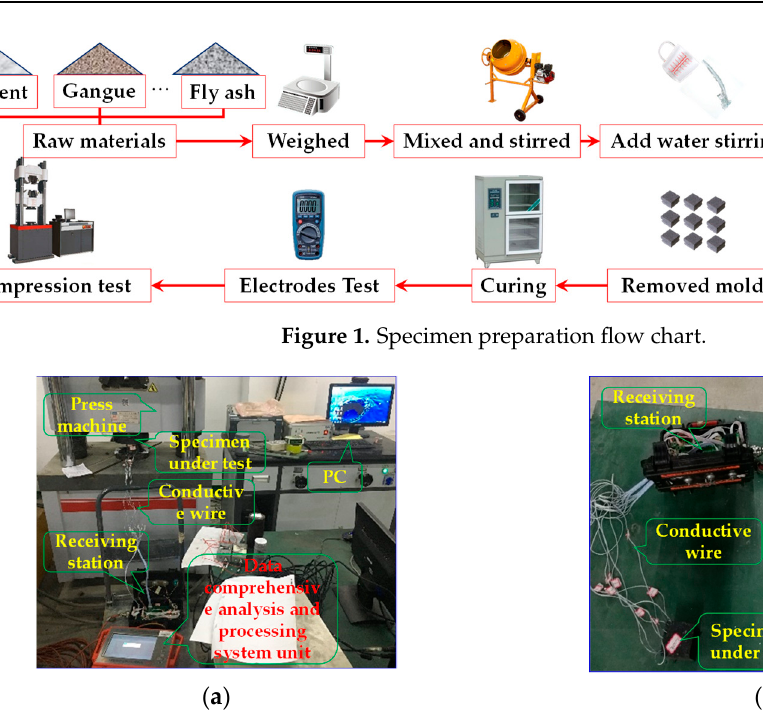
Figure 2. Illustration of resistivity test. ( a ) non-zero stress conditions. ( b ) zero stress conditions.